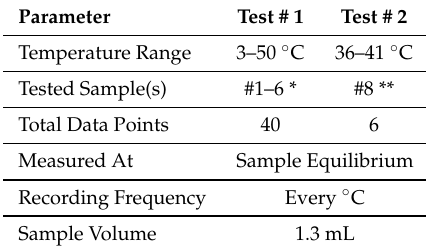
Table 2. Density Testing